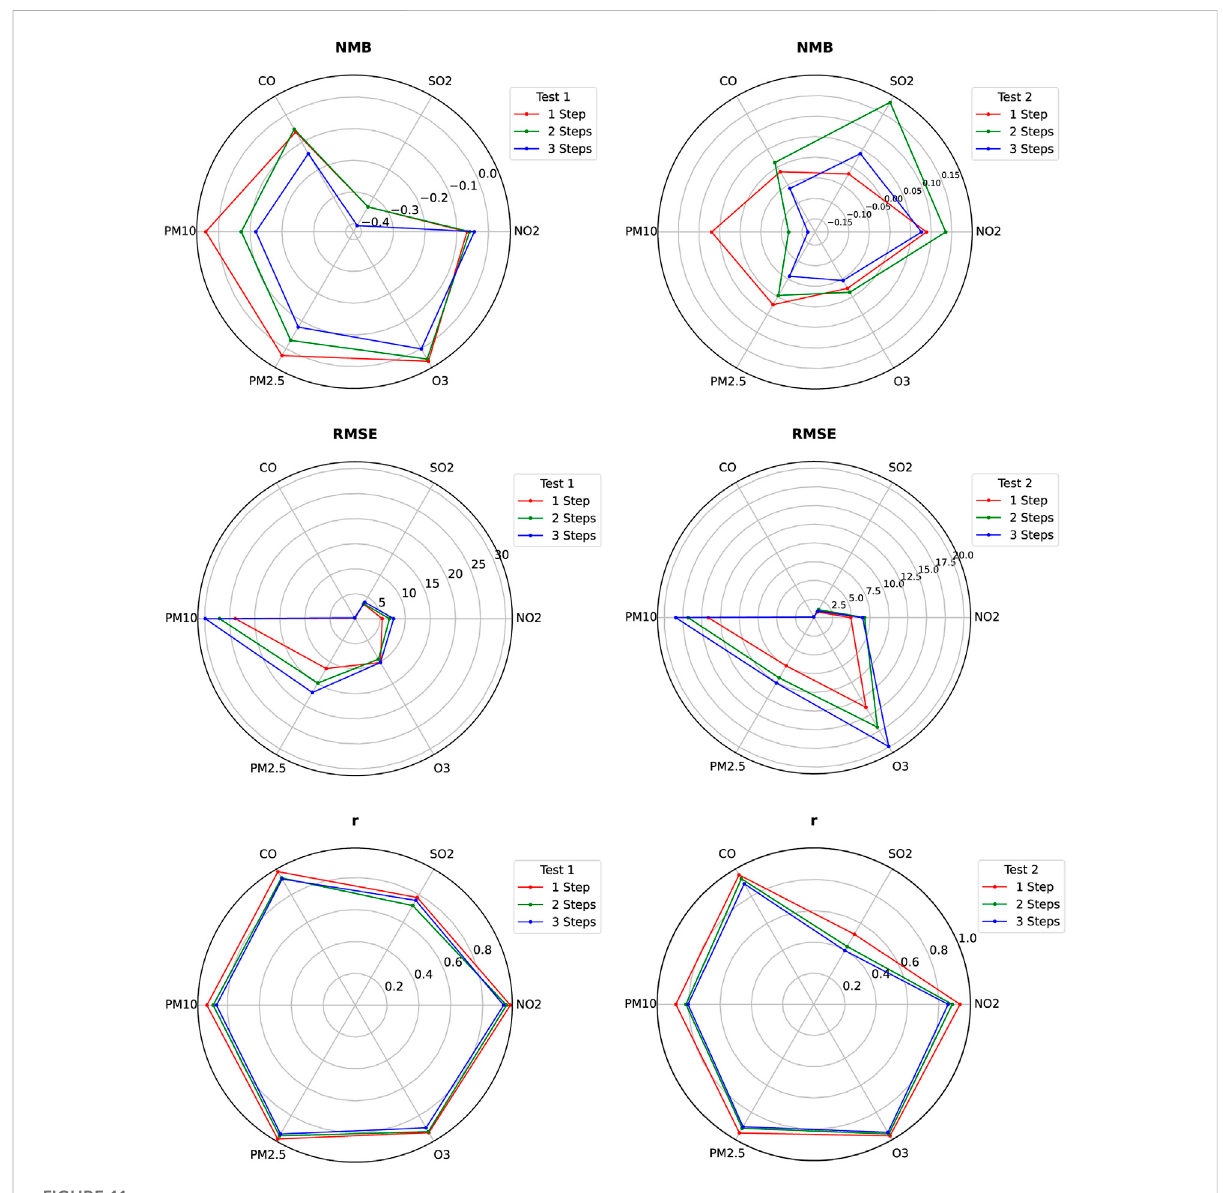
FIGURE 11 The radar chart of pollutant concentration prediction of TSTM in